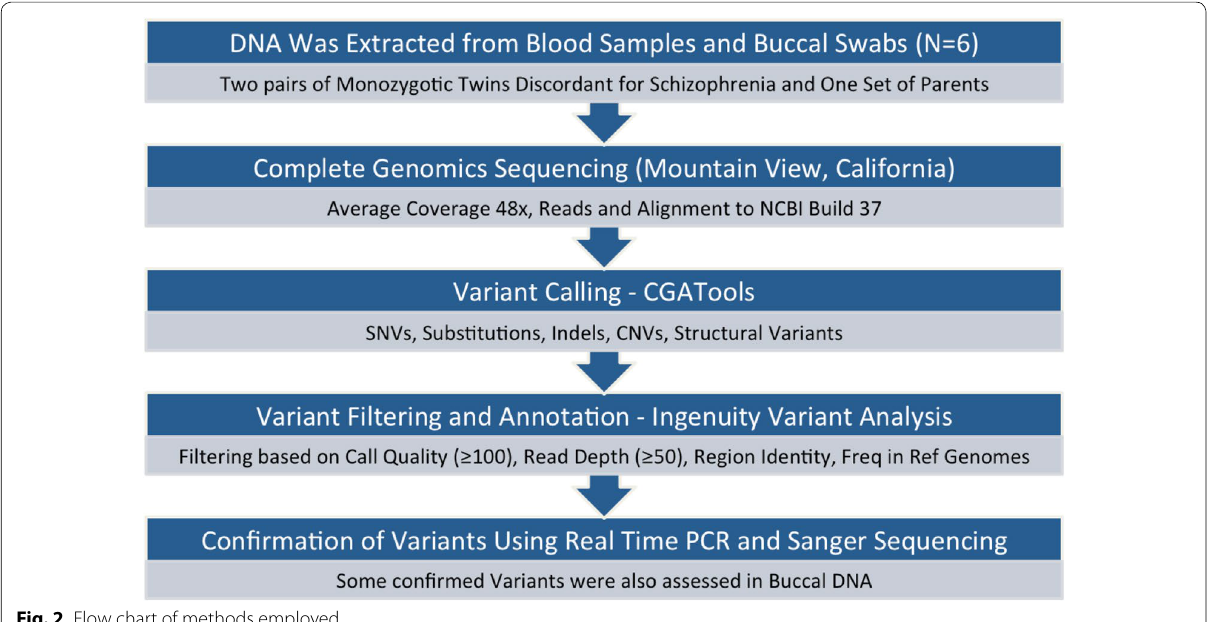
Fig. 2 Flow chart of methods